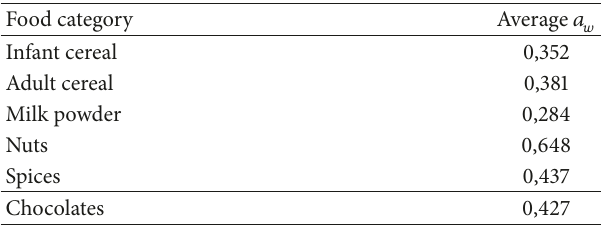
Table 1: Average water activities for the low 𝑎 𝑤 food samples collected from